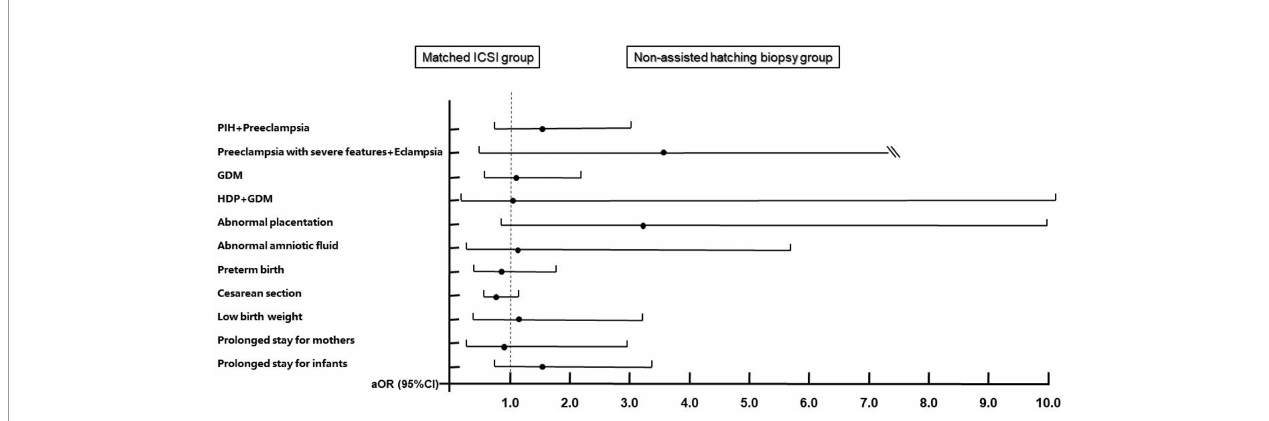
FIGURE 4 | Adjusted odds ratios and 95% con fi dence intervals for maternal and neonatal outcomes after matching. Adjusted for maternal age, maternal BMI, times of previous miscarriages, parity, endometrial preparation protocols, endometrial thickness of transfer day, hCG ratio, PCOS, thyroid disorders, chronic hypertension, family history of hypertension, diabetes, family history of diabetes, and history of uterine surgery. Matched ICSI group is the reference group. PIH, pregnancy-induced hypertension; GDM, gestational diabetes; HDP, hypertensive disorders of pregnancy.